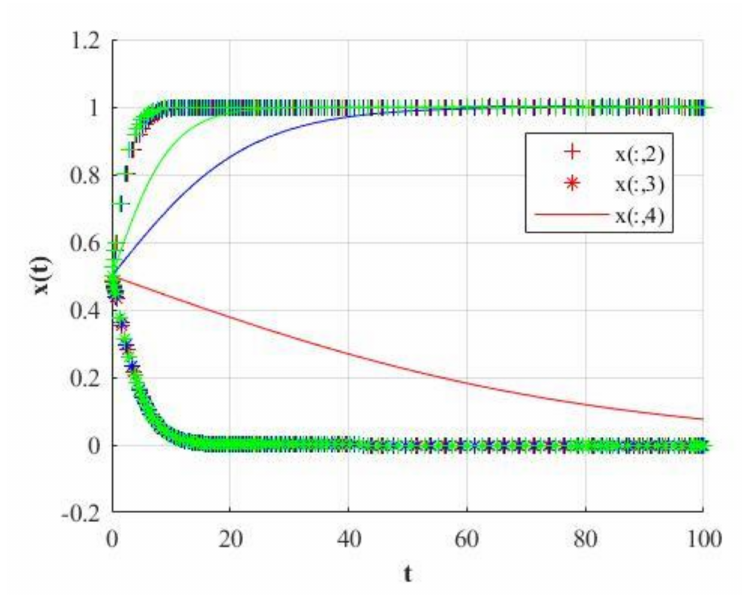
Figure 19. Change the parameter δ 2 , δ 4 , λ 1 = (0.8,0.2,0.8) red curve, (0.5,0.5,0.5) blue curve, (0.2,0.8,0.2) green curve to take the value of the three-way strategy evolution diagram.